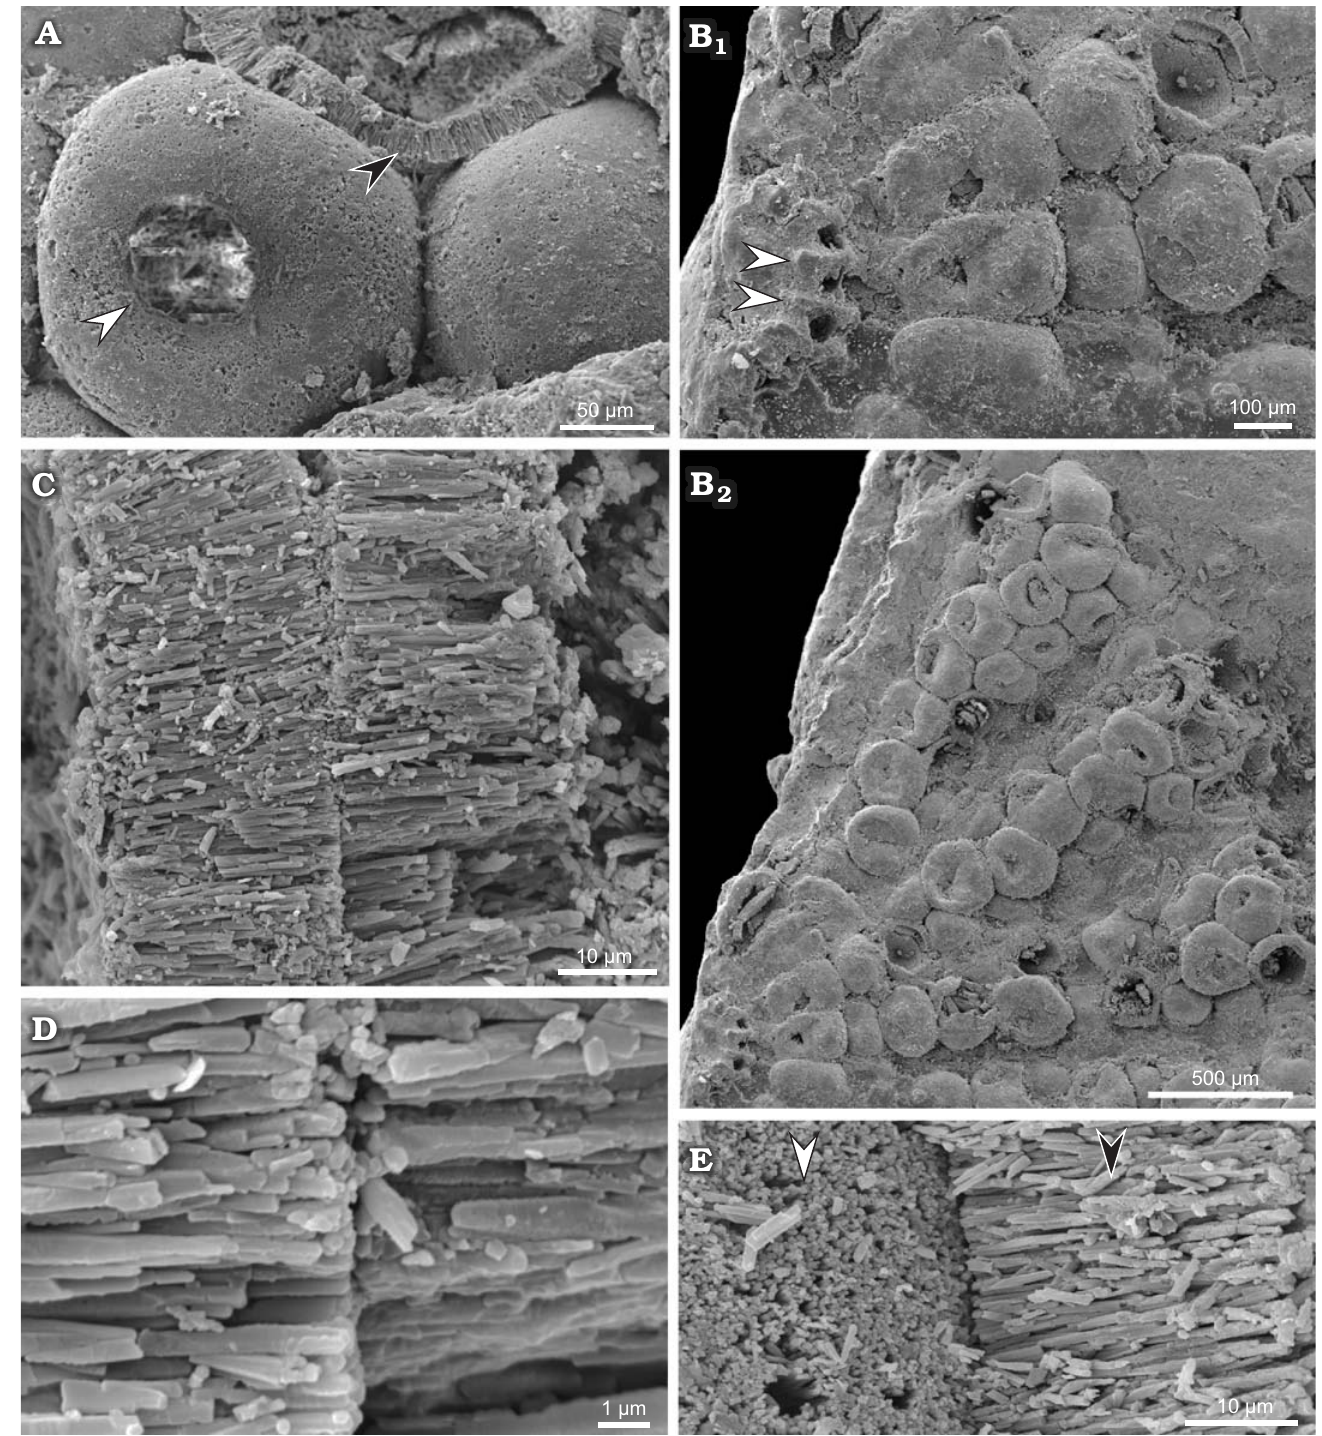
Fig. 7. Polyphysacean alga Acetabularia moldavica sp. nov., early Sarmatian, P ă tr ă u ț i (Suceava County, Romania). A . MP-UAIC 8228/PD.1, three min- eralized gametangia (cysts), one shows the opening (white arrow head), another shows the fibrous layer (black arrow head); notice the empty space (not filled by calcareous matrix) between gametangia (cysts). B . MP-UAIC 8228/PD.1, part of a fertile disc, the coronal structure with three spicules, promi- nences (white arrow heads) correspond to mineralized walls among the basal parts (furrows) (B 1 ), pores probably represent the communication to the lower coronae; general view of spicules with mineralized cysts (B 2 ). C . MP-UAIC 8228/PD.1, contact between fibrous aragonitic layers of two gametan- gia (cysts). D . MP-UAIC 8228/PD.1, sharp contact between two fibrous layers. E . MP-UAIC 8228/PD.1, contact between two gametangia (cysts), outer surface of the mineralized layer (white arrow head) and aragonitic fibrous structure of a broken cyst layer (black arrow